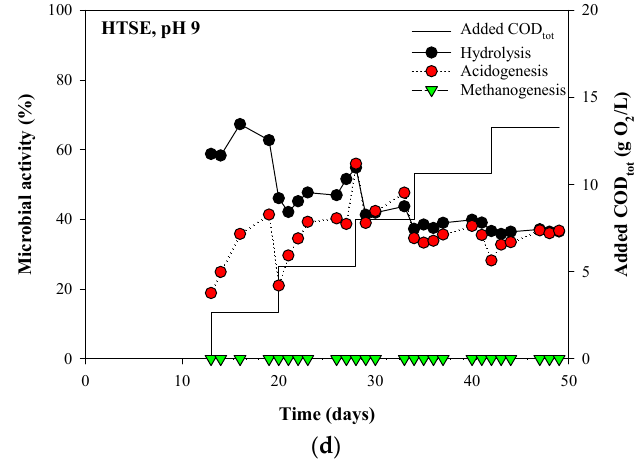
Figure 5. Relation of the stages of anaerobic digestion processes at a pH of 5 from ( a ) SE and ( b ) HTSE and at a pH of 9 from ( c ) SE and ( d ) HTSE.